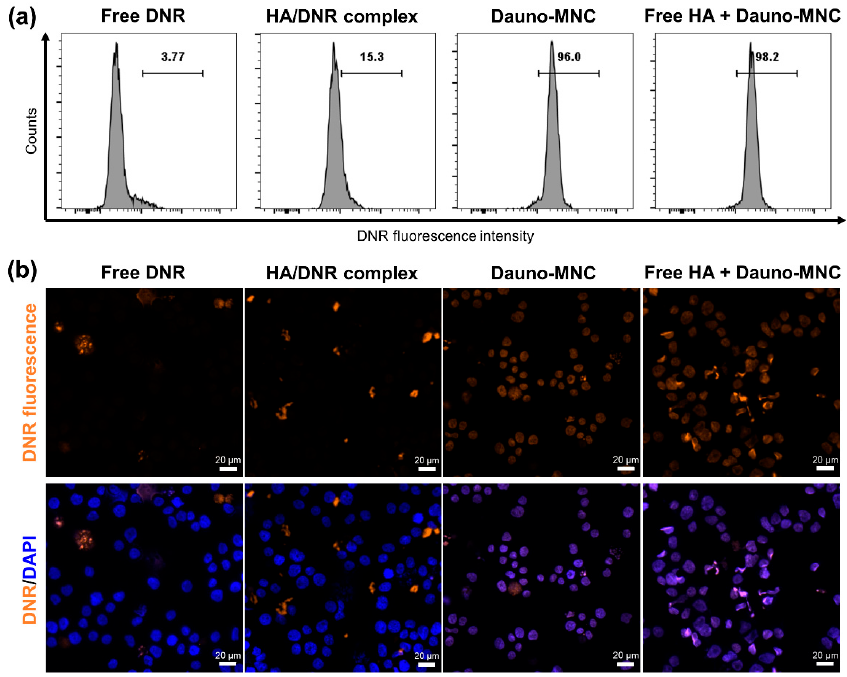
Figure 6. ( a ) Flow cytometric analysis of DNR fluorescence intensity of HL-60/MX2 cells treated for 4 h with free DNR, HA/DNR complex and Dauno-MNC without or with excess free HA at a final DNR concentration of 1.6 µM. The gate was selected after analyzing untreated HL-60/MX2 cells. ( b ) Fluorescence microscopic images of HL-60/MX2 cells subjected to different treatments. Orange and blue fluorescence show the intracellular distribution of DNR and nucleus, respectively. Scale bar = 20 µm. 2.7. Intracellular ROS Production and Caspase Activation In addition to drug efflux transporters, augmented antioxidant defense has been recognized as another key contributor to the mechanism of multidrug resistance in leukemic cells [39,40]. Upon cellular internalization, DNR is known to undergo metabolic reduction to generate ROS, such as superoxide (O 2 • − ) and hydroxyl radical (•OH), which can cause chromosomal damage associated with its cytotoxic action [41]. In this perspective, we attempted to monitor the intracellular ROS generation in HL-60/MX2 cells by using the fluorogenic ROS probe CM-H 2 DCFDA [42]. The cells preloaded with CM- H 2 DCFDA displayed intense green fluorescence upon treatment of free DNR for 1 h relative to untreated cells (Figure 7a), validating that the increased fluorescence was caused specifically by the internalized DNR, not by oxidative endogenous enzymes in the cells [43]. Notably, we detected dramatically elevated ROS levels in the cells treated with Dauno-MNC, as compared to the free DNR and HA/DNR complex. This finding was further supported by the fluorescence intensity data, in which Dauno-MNC treatment caused a substantial rise in the intracellular ROS levels to ~450%, while only a modest increase in ROS levels (~130%) was induced by the free DNR and HA/DNR complex